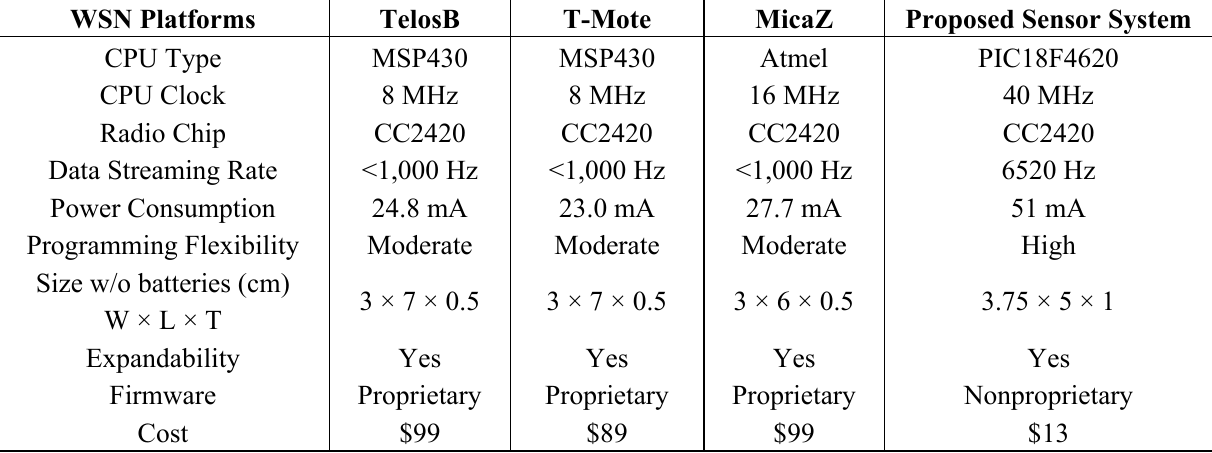
Table 4. Comparison of alternative WSN